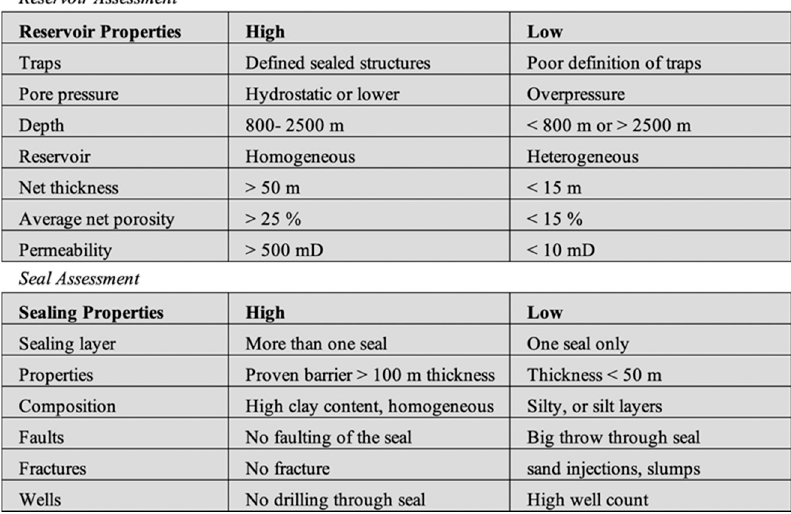
Figure A2. Attribute list for Boston square analysis [71,82].